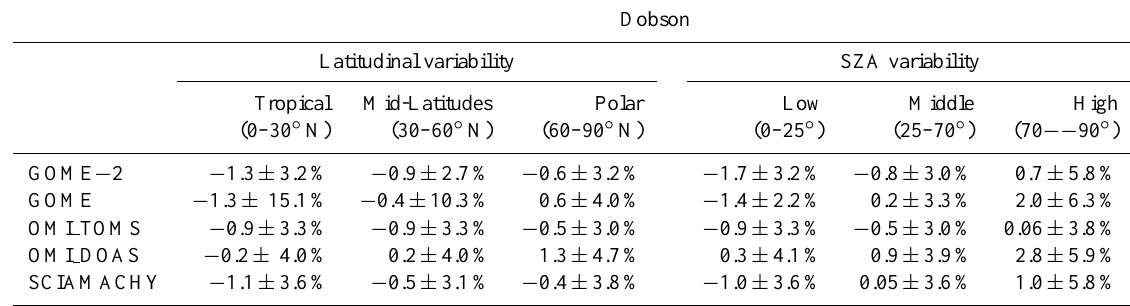
Table 3. The average differences between satellite and ground-based instruments for the five datasets shown in this paper. The mean and standard deviation for the latitudinal and the SZA variability are given for the Dobson instruments for low, middle and high latitudes and angles